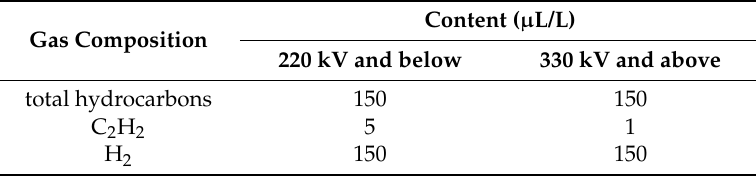
Table 5. Attention values of dissolved gas content in power